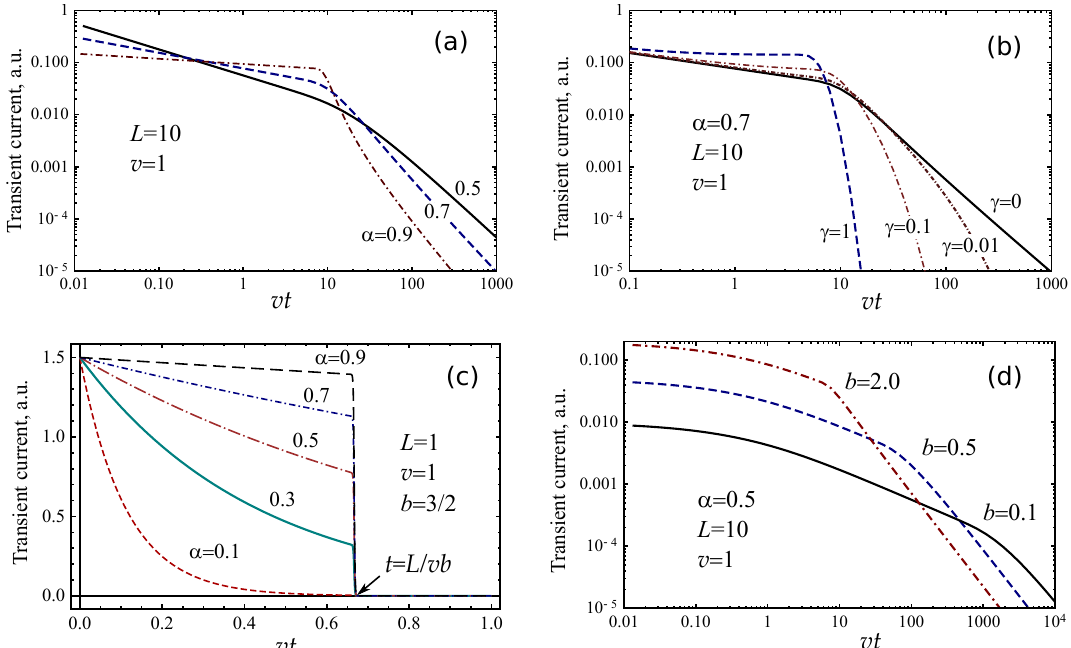
Figure 2. Transient current for dispersive transport described by drift-diffusion equations with different fractional time-derivative operators. The curves are calculated by using Formula